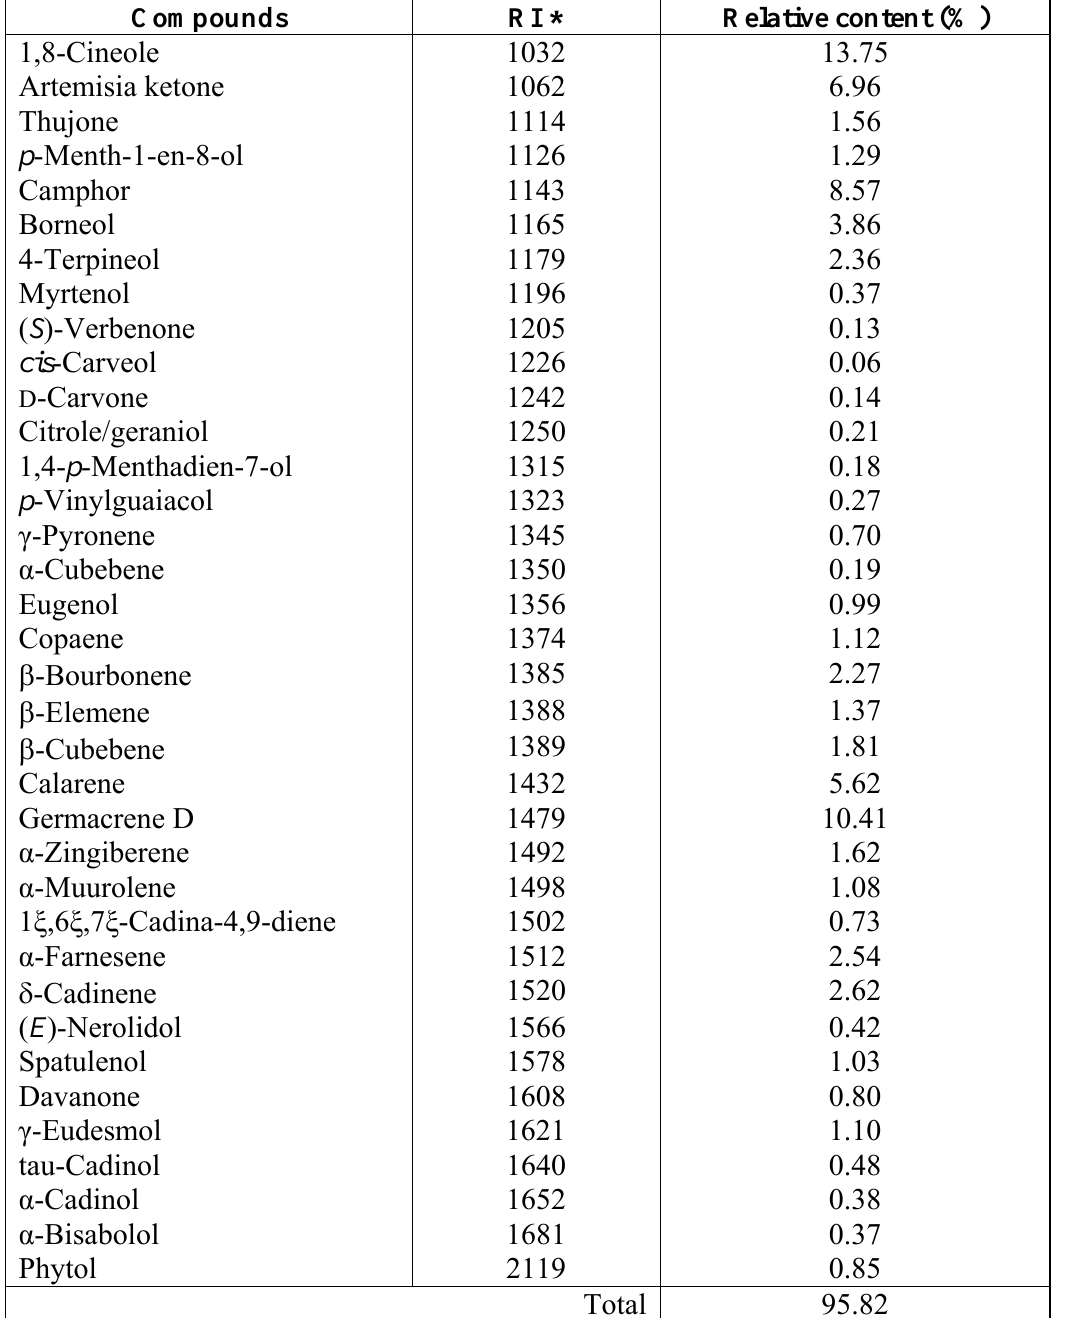
Table 1. Chemical composition of the essential oil of Artemisia mongolica